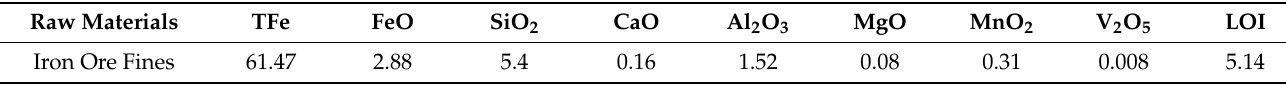
Table 1. Chemical composition of raw